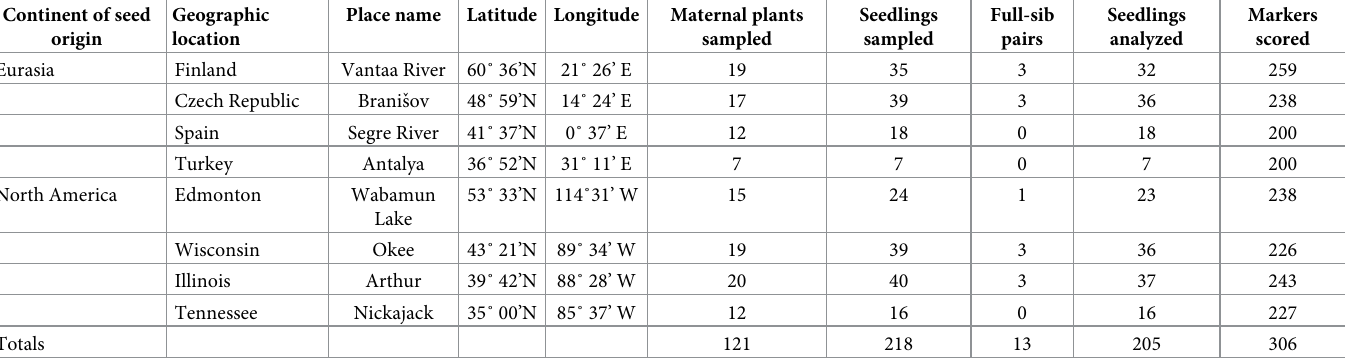
Table 1. Seed collection locations of Lythrum salicaria used in the common garden studies in cold vs. hot gardens (T ř ebo ň , Czech Republic vs. Lafayette, Louisiana). Continent of seed